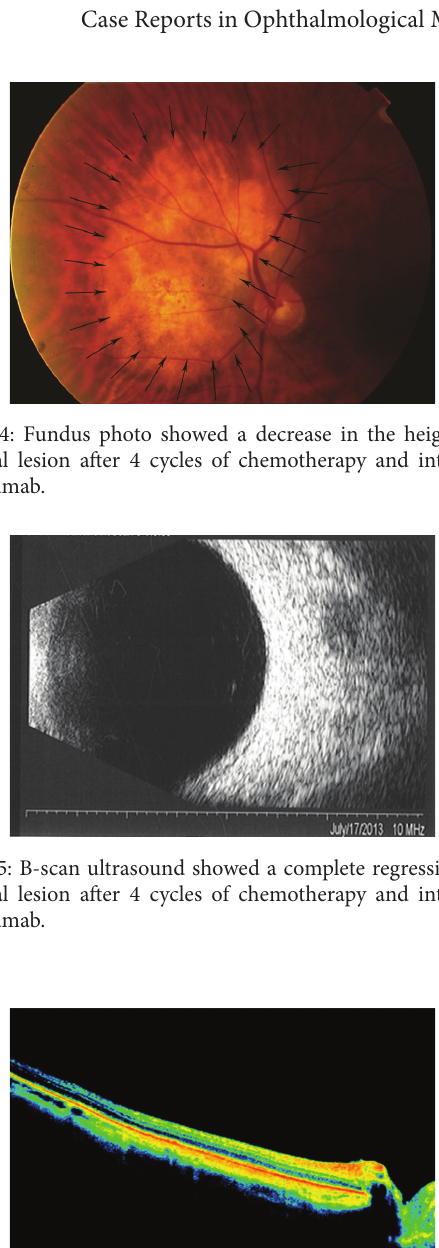
Figure 6: Optical coherence tomography of the left eye showed a complete resolution of the subretinal fluid after 4 cycles of chemotherapy and intravenous